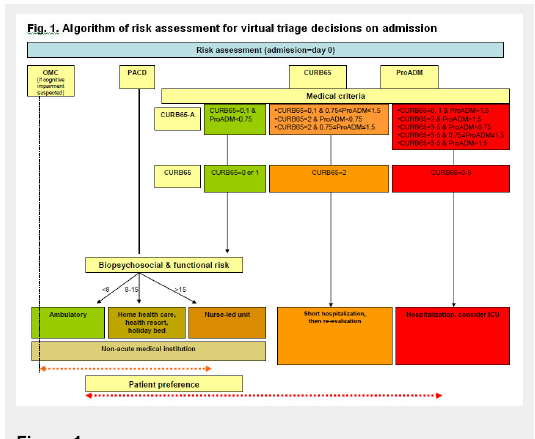
Algorithm of risk assessment for virtual triage decisions on admission. Triage algorithm based on medical and functional risk assessment for patients with lower respiratory tract infection on admission. OMC – orientation memory concentration test for assessment of cognitive impairment; PACD – post acute care discharge score; ProADM – proadrenomedullin; ICU – intensive care